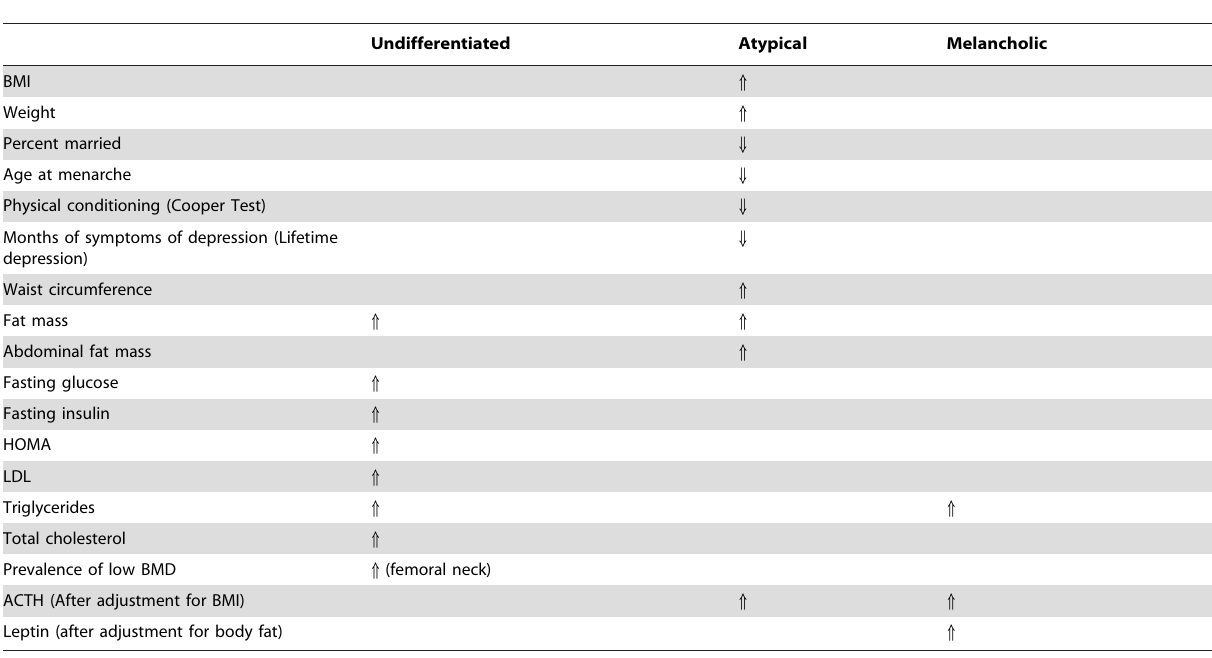
Table 4. Synopsis of significant findings in the three subtypes of depression vs. healthy